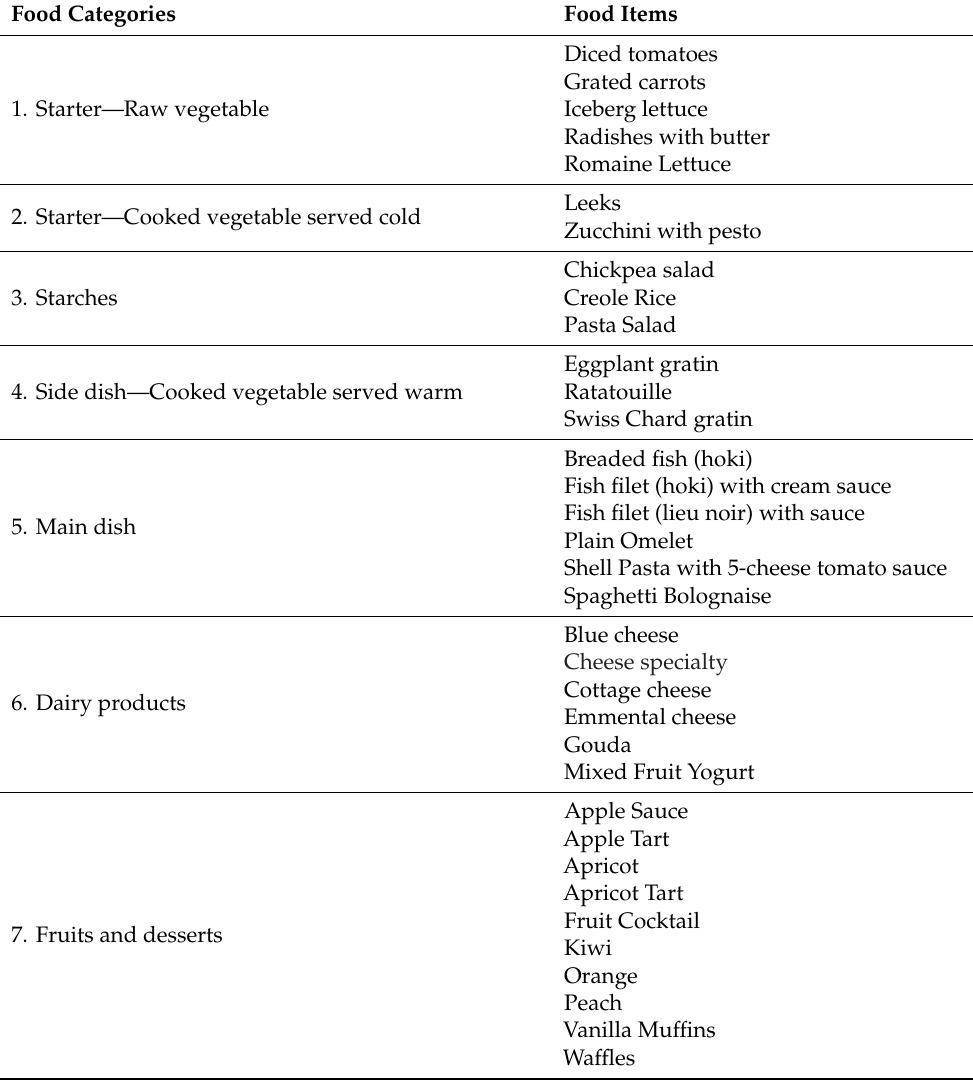
Table 3. Food items and food categories served during the 5 observation